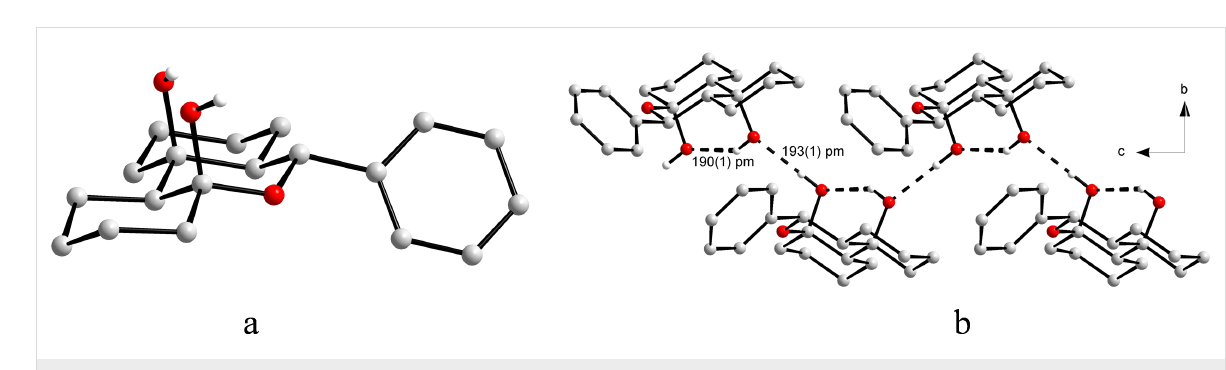
Figure 2: (a) Crystal structure of 7h and (b) its arrangement in the crystal [43].